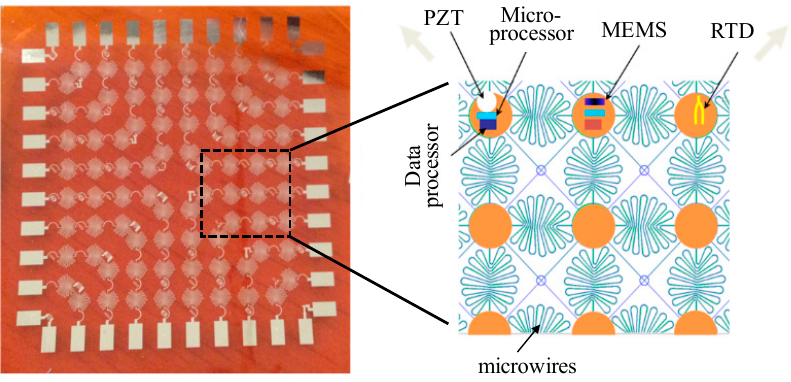
Figure 12. Expandable multifunctional sensor network.